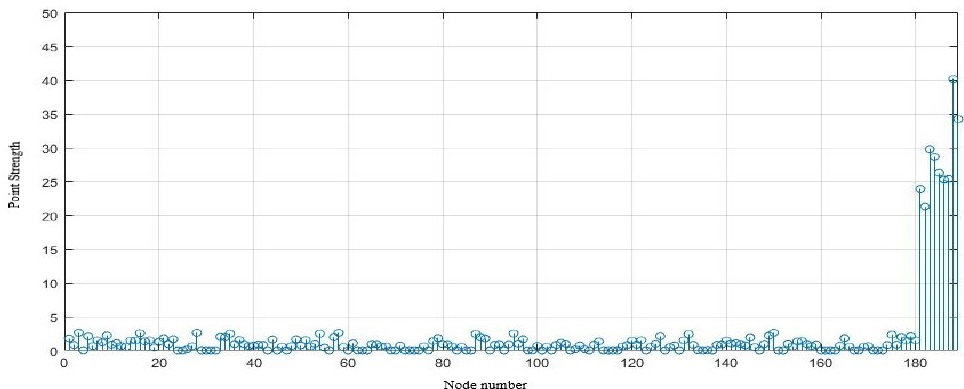
Figure 9. Node node intensity.